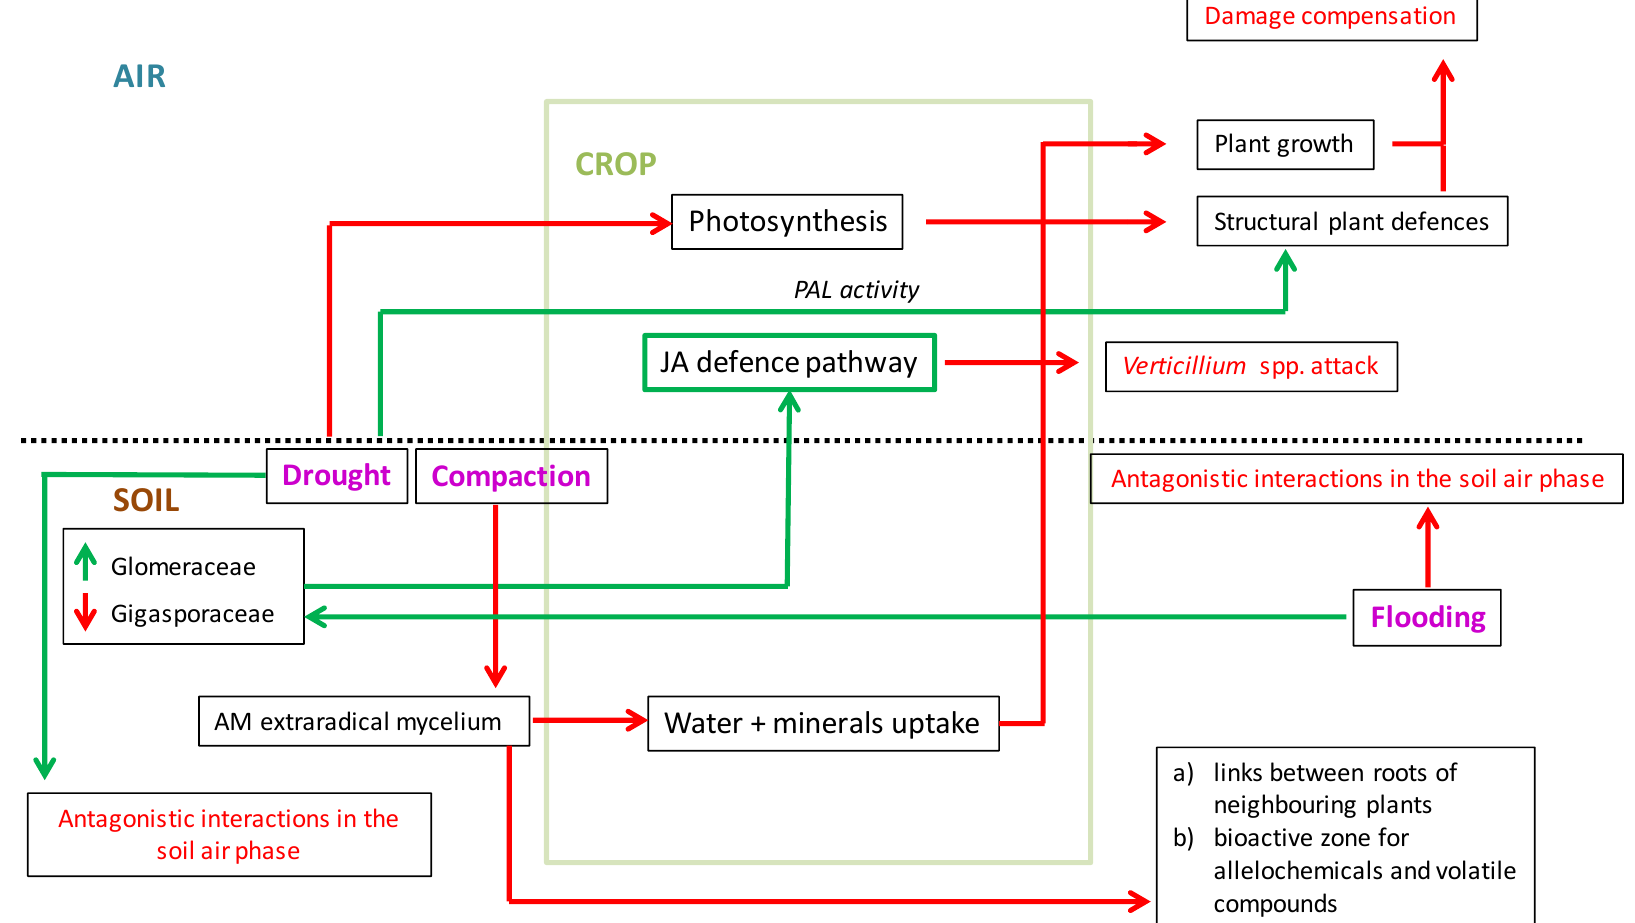
Scheme 2. Hypothetical effect of elevated CO 2 in the air and elevated soil temperature on the role of arbuscular mycorrhizal fungi (AMF) as bioprotectors of crops against Verticillium wilt modified by the irruption of erratic rainfall and severe drought periods. Green arrows indicate “induced or increased”, and red arrows indicate “ avoided or decreased ’ . AM = arbuscular mycorrhizae; JA = Jasmonic acid; PAL = phenylalanine ammonia lyase.